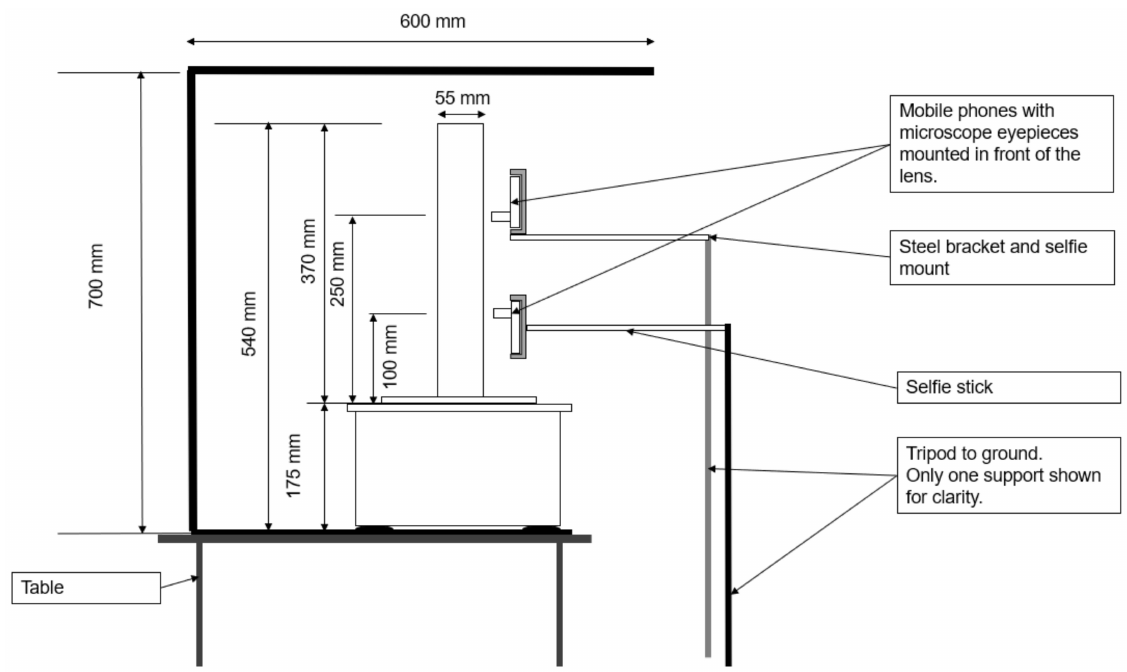
Figure 4. Experiment 2 setup—side